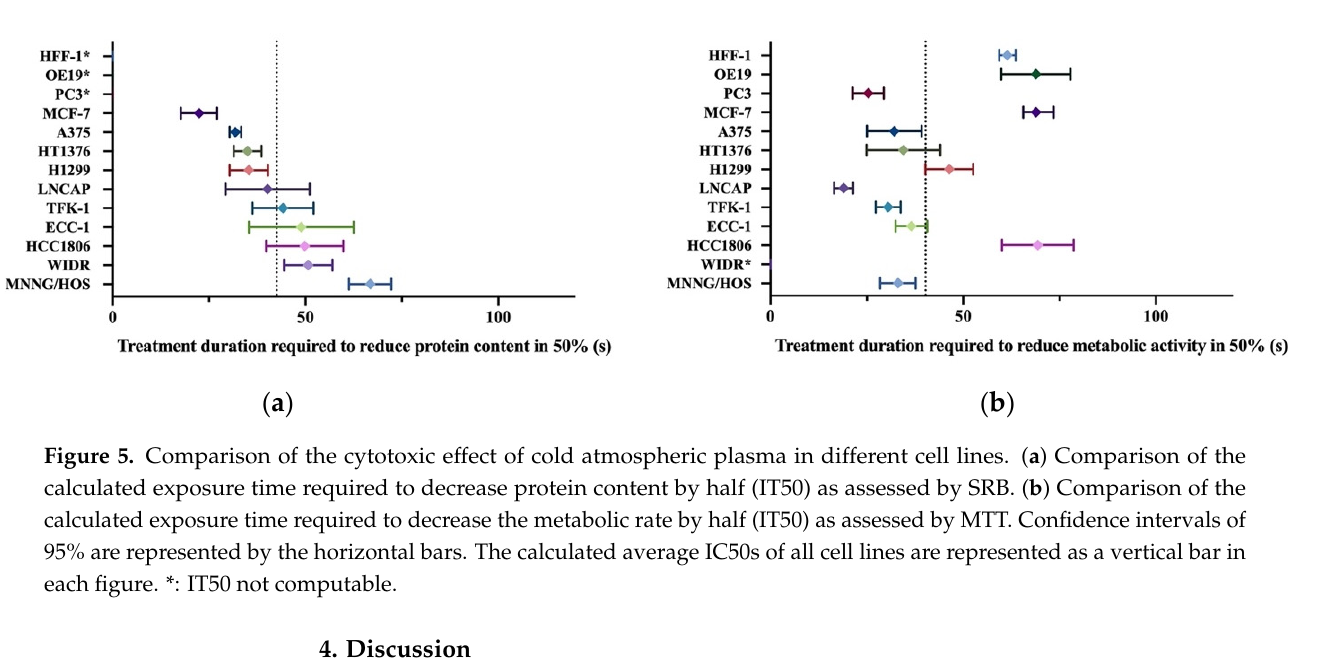
Figure 4. Accumulation of RONS in different CAP irradiated media. ( a ) Concentration of peroxides in 200 µL of exposed media. ( b ) Concentration of nitrites in 200 µL of exposed media. Results are presented as the mean ± SEM of at least three repeated experiments performed in triplicate and normalized for the control of non-irradiated medium. The significance compared is indicated as * p < 0.05, ** p < 0.01, and *** p < 0.005.